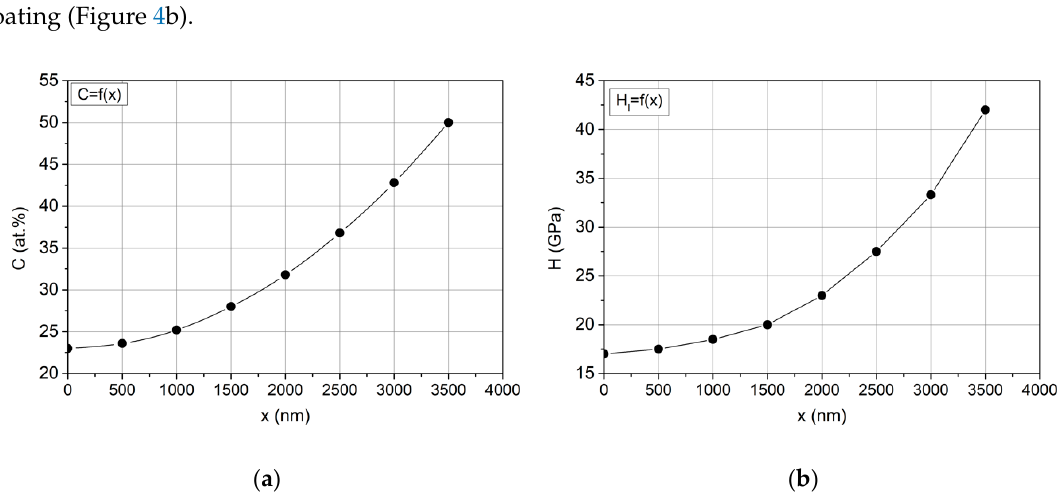
Figure 4. ( a ) Change in carbon content in coating according to parabolic profile in the range of 0–50 at.% determined according to Formula (3), and ( b ) change in coating hardness determined from accepted carbon content profile and changes in hardness calculated according to mixtures rule (Formula (1)).